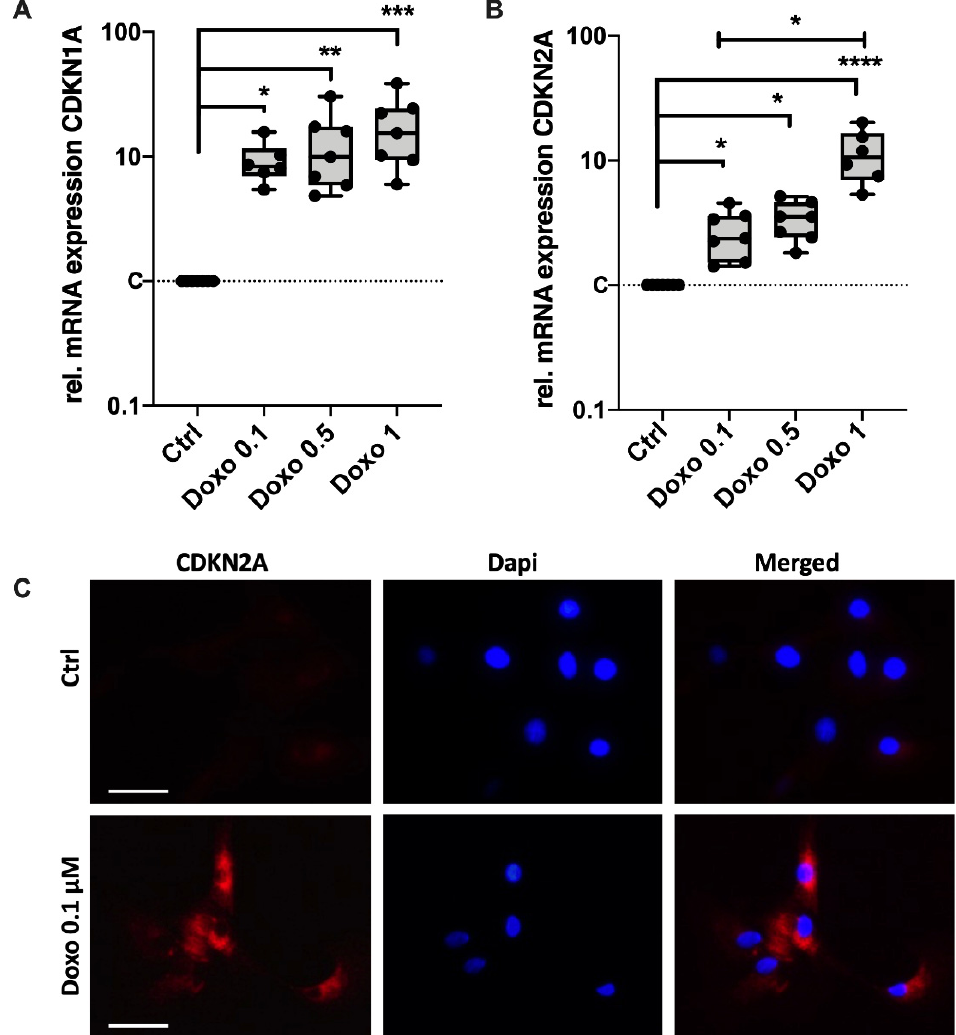
Figure 2. Effect of Doxo stimulation on the expression of key senescence regulators CDKN1A and CDKN2A. Gene expression analysis of ( A ) CDKN1A (p21) and ( B ) CDKN2A (p16) in hAC after 10 d of Doxo stimulation at different concentrations; unstimulated hAC served as controls. ( C ) Exemplary images of a CDKN2A immunostaining in hAC after stimulation with 0.1 μ M Doxo for 7 d. Data are presented as box plots with median, whiskers min to max. Significant differences between groups are depicted as: **** p ≤ 0.0001; *** p ≤ 0.001; ** p ≤ 0.01; * p ≤ 0.05. Statistical analysis: ( A , B ) One-way ANOVA, Sidak’s multiple comparison. Scale bar = 50 μ m. Ctrl = control (unstimulated cells), dapi = 4 ′ ,6-diamidino-2-phenylindole.